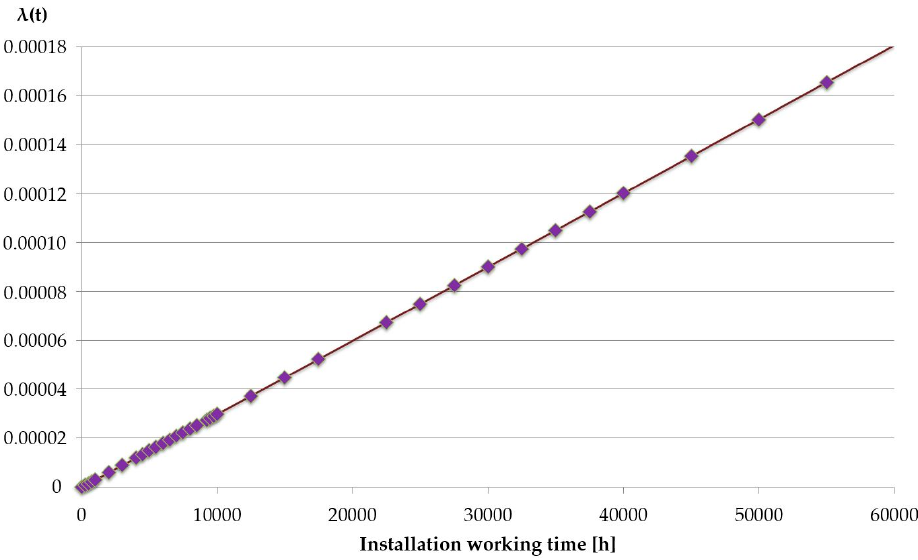
Figure 8. Distribution of the damage intensity function λ (t) of the CHP plant in time.